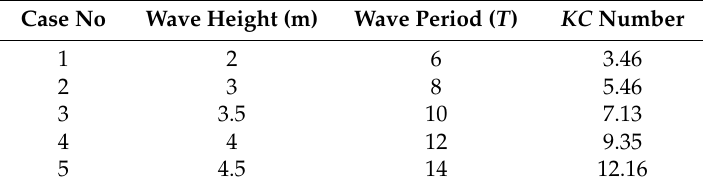
Figure 10. Variations of the pile group effect versus various submerged coefficients of the cap with different arrangements of the pile group. It is easily concluded from Figure 10 that the tendency of the change of the pile group effect is similar between the side-by-side and tandem arrangements of the pile group versus different submerged coefficients of the cap. The pile group effects are more sensitive to the side-by-side